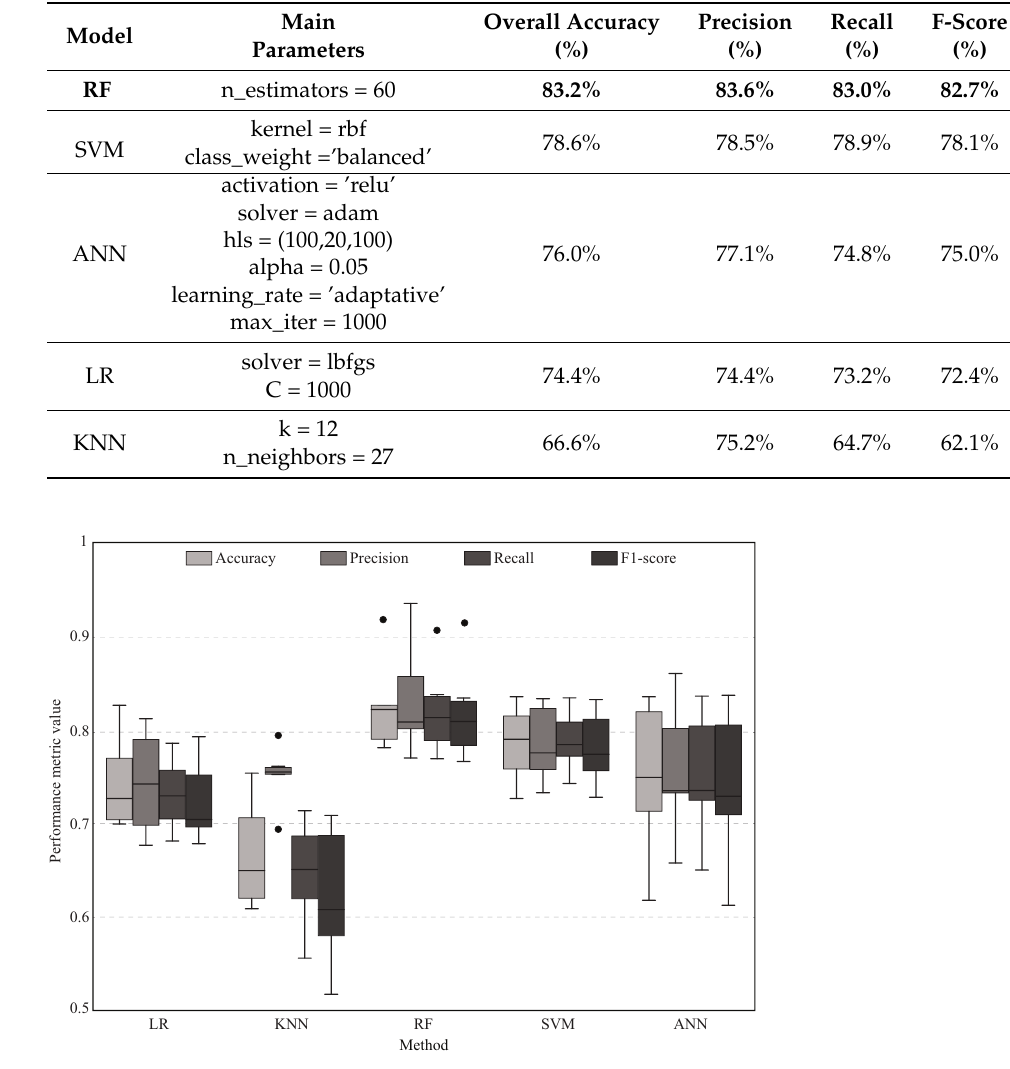
Figure 16. Box plot of the performance metric results for the five best machine learning